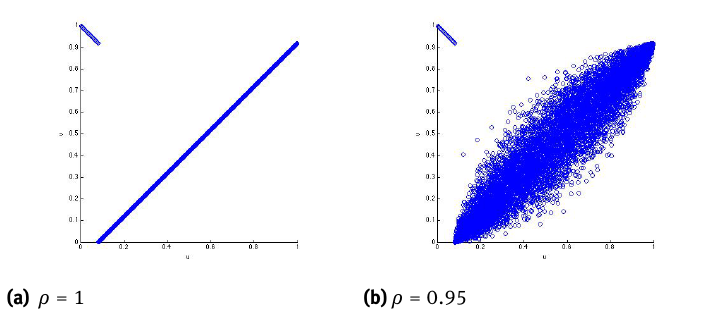
Figure 2: Patchwork copula C r ( u , v ) presenting two states depending on the value of u: the first copula is in the upper left part of the plan and is W ; the second one is the Gaussian copula with correlation equal to ρ, with ρ = 1 that is the degenerated copula M (cid:1) with η = 0.2 or ρ = 0.95 . r is equal to 2 Φ (cid:0) − η 2